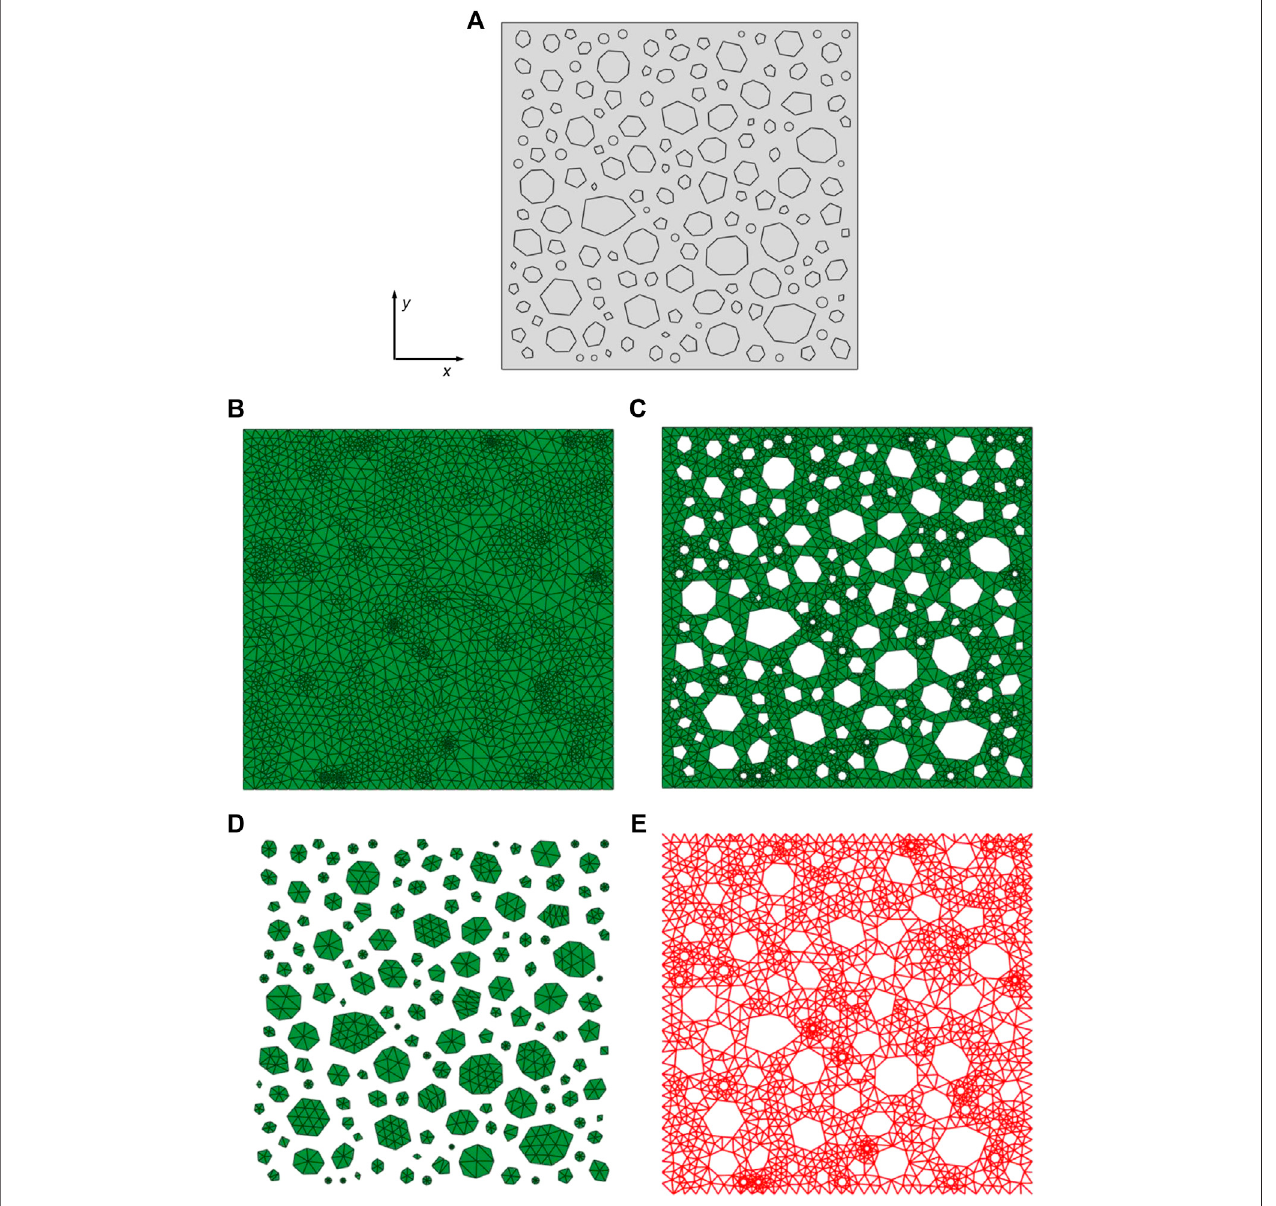
FIGURE2|(A) Geometricplanemodelofaconcretespecimen; (B) Numericalmodeloftheconcretespecimen; (C) Elementsofthecementmortarmatrix(element type: CPE3T); (D) Elements of the aggregates (element type: CPE3T); (E) Cohesive elements embedded into the cement mortar matrix (element type: